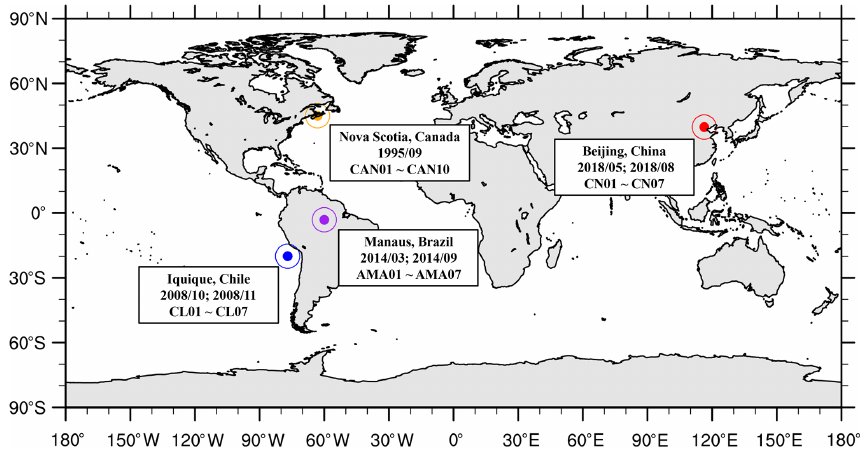
Figure 4. The geographical distribution of 31 selected cloud cases in the four aircraft campaigns. The text boxes provide the locations, the periods, and the names of the cloud cases for each campaign.